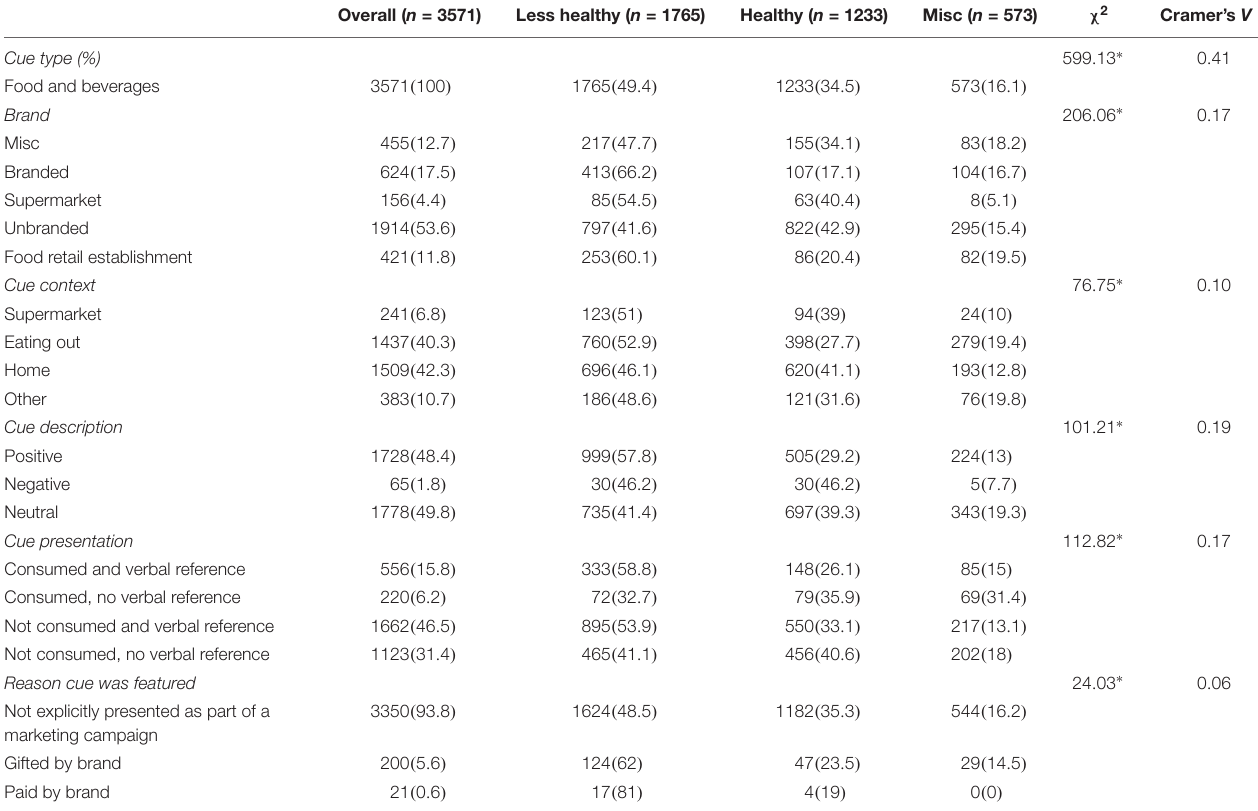
TABLE 3 | Frequency of food and beverage cues in each presentation category, split by category according to the UK Nutrient Profiling Model (healthy, less healthy, or